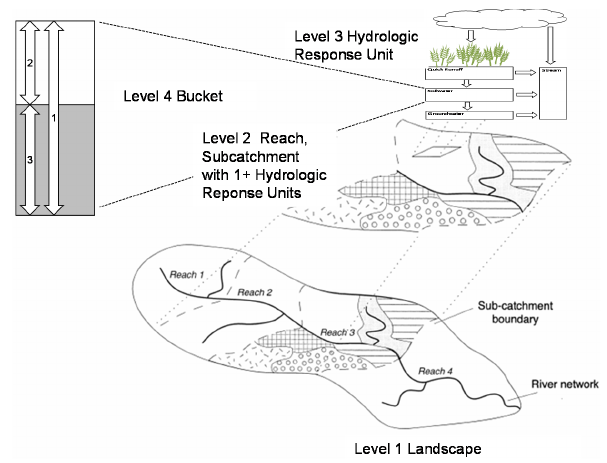
Fig. 1. Conceptual representation of the landscape in PERSiST adapted from Wade et al. (2002). A watershed (level 1) is repre- sented as one or more reach/subcatchments (level 2). Within each subcatchment, there are one or more hydrologic response units (level 3). Each hydrologic response unit is made up of one or more buckets through which water is routed (level